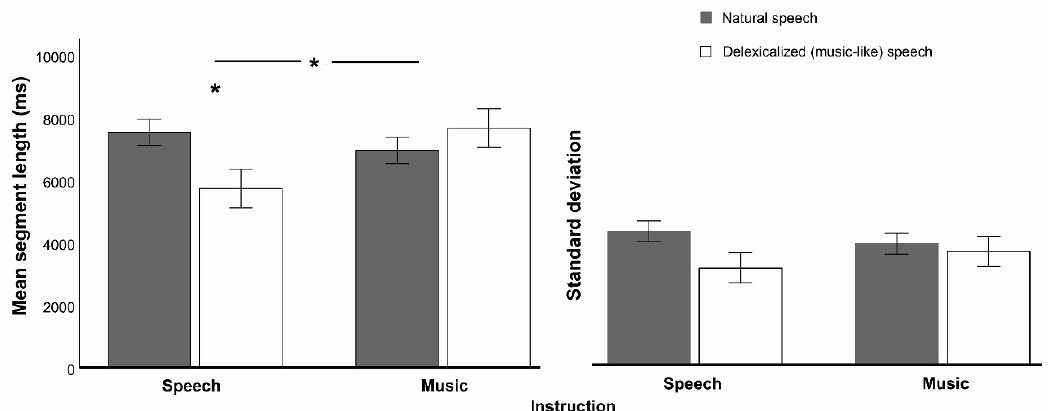
Figure 2. Delexicalization and instruction effects on the mean (left) and standard deviation (right) of segment length. Participants under the speech instruction decreased segment length in delexicalized versions, while those under the music instruction did not show any change. The standard deviation (variability) decreased in delexicalized versions for both instruction levels. Vertical bars represent the standard error of the mean.